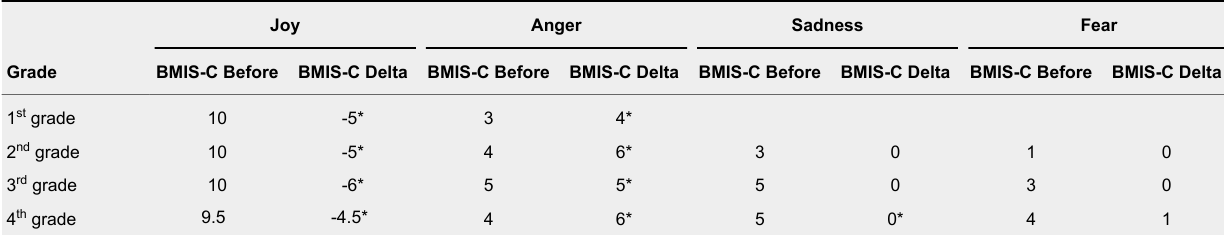
Evolution of the Emotional State Before and After Anger Induction, According to the Student’s Grade and the Induced Emotion Joy Anger Sadness Grade